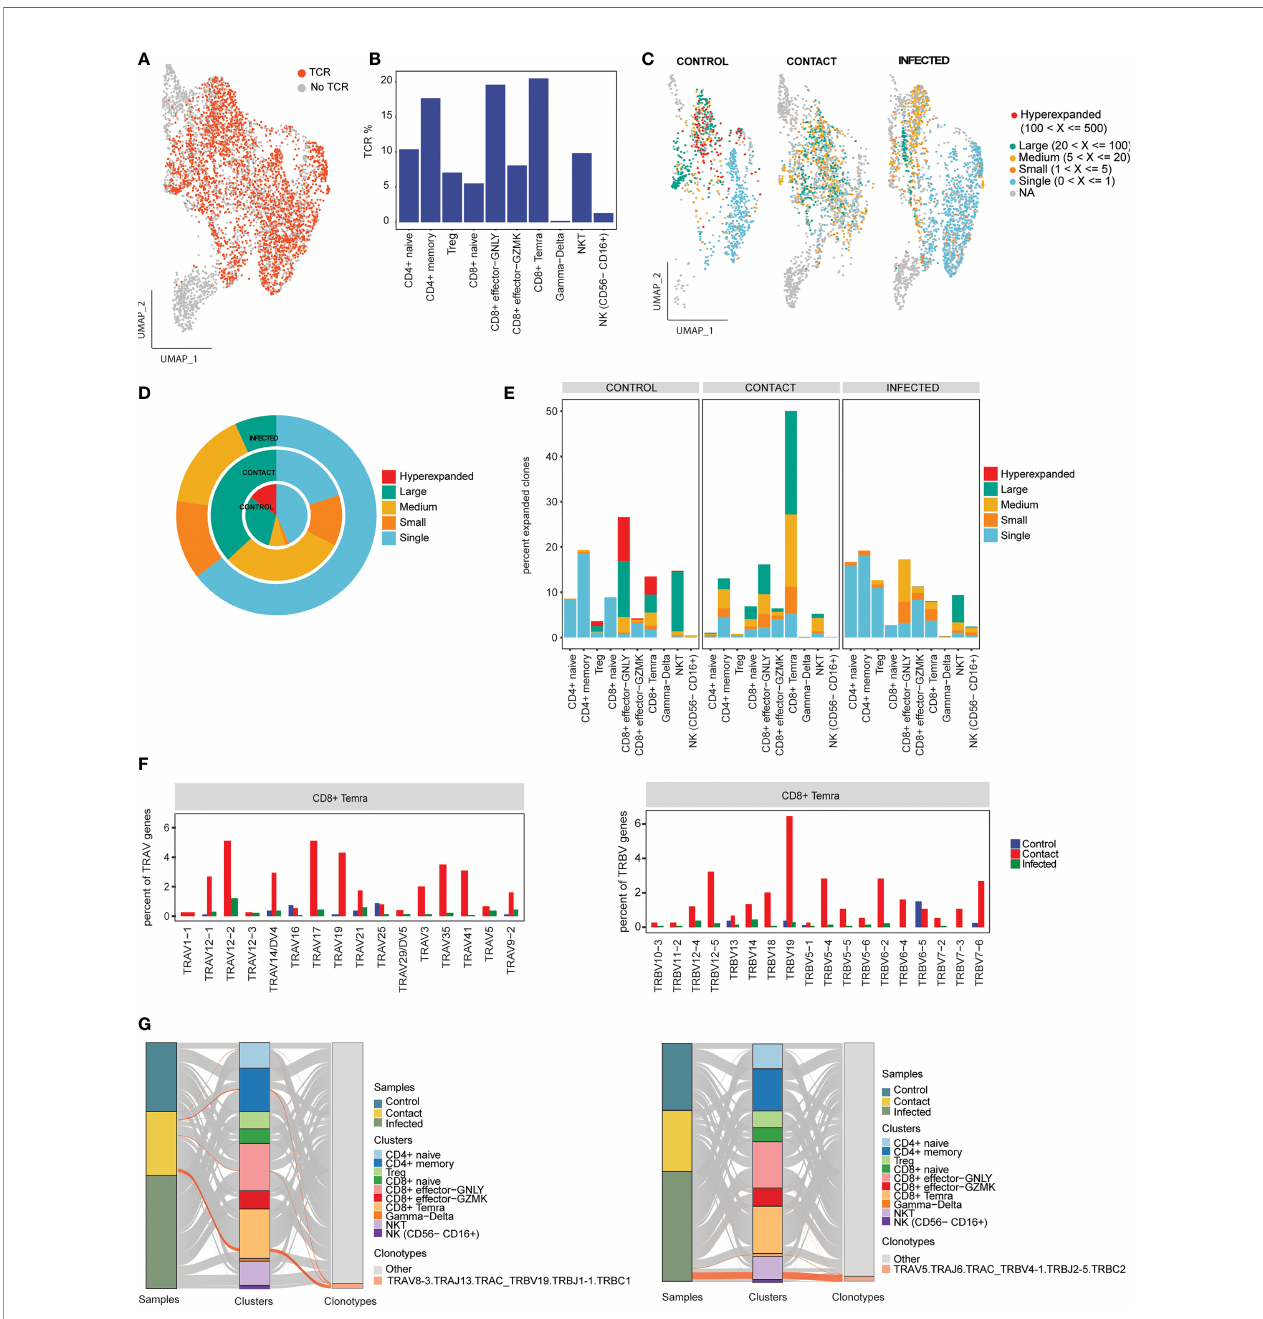
FIGURE 5 | Clonal expansion of T-cell receptors. (A) UMAP representation of T/NK/NKT cells colored by TCR detection. (B) Bar plot showing percentage of TCR detected in each cell cluster. (C) UMAP representation of T/NK/NKT cells colored by their clonal expansion status. Clones were de fi ned as single (n = 1), small (1 < n ≤ 5), medium (5 < n ≤ 20), large (20 < n ≤ 100), and hyperexpanded (100 < n ≤ 500). (D) Nested pie plots showing the clonal status across controls, contacts, and infected patients. (E) Bar plot showing percentage of expanded clonotypes in each cluster across samples. (F) Bar plots showing usage of some TRA genes (left) and TRB genes (right) in CD8 + Temra cell-type across subject groups. (G) Alluvial plots showing relationship of the top V(D)J pairing frequencies of expanded clonotypes for contacts (left) and infected patient (right) between samples and cell